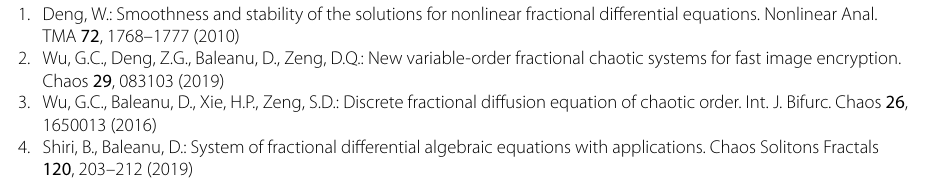
merical simulation of (5.4) and (5.7) with ξ + η = 2,1,0,–1,–2, respectively, represent five solutions of (5.3) with the corresponding ρ